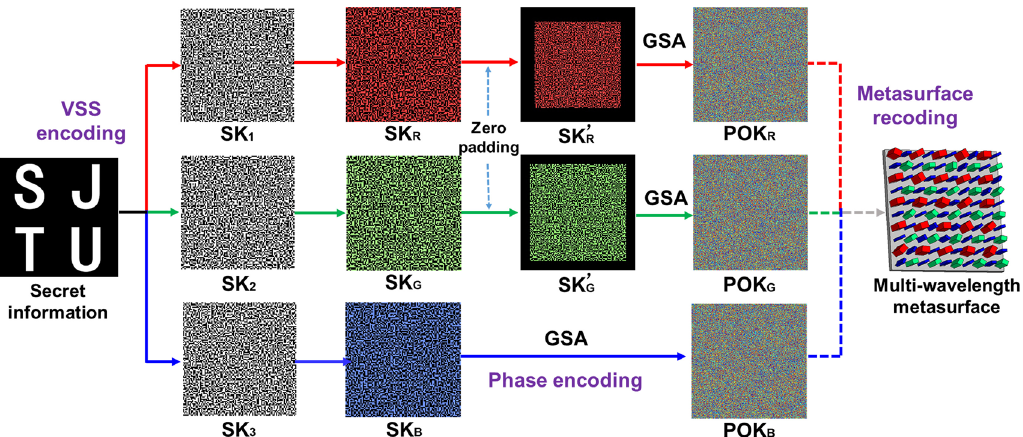
Figure 5: A flowchart of SSPE algorithm to generate a set of shared phase-only